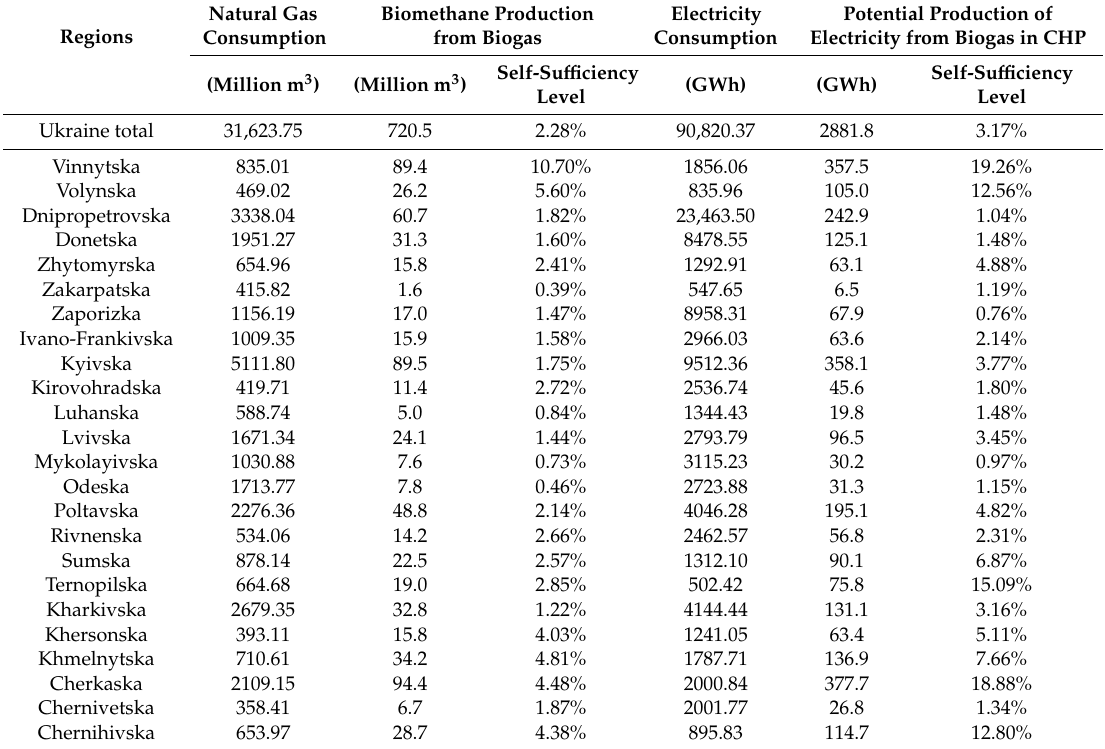
Table 6. Technically possible production of agricultural biogas to energy